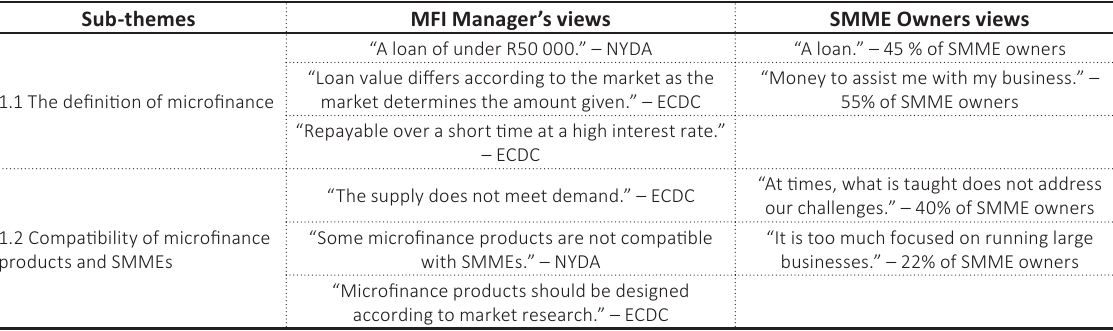
Table 1. Participants understanding microfinance